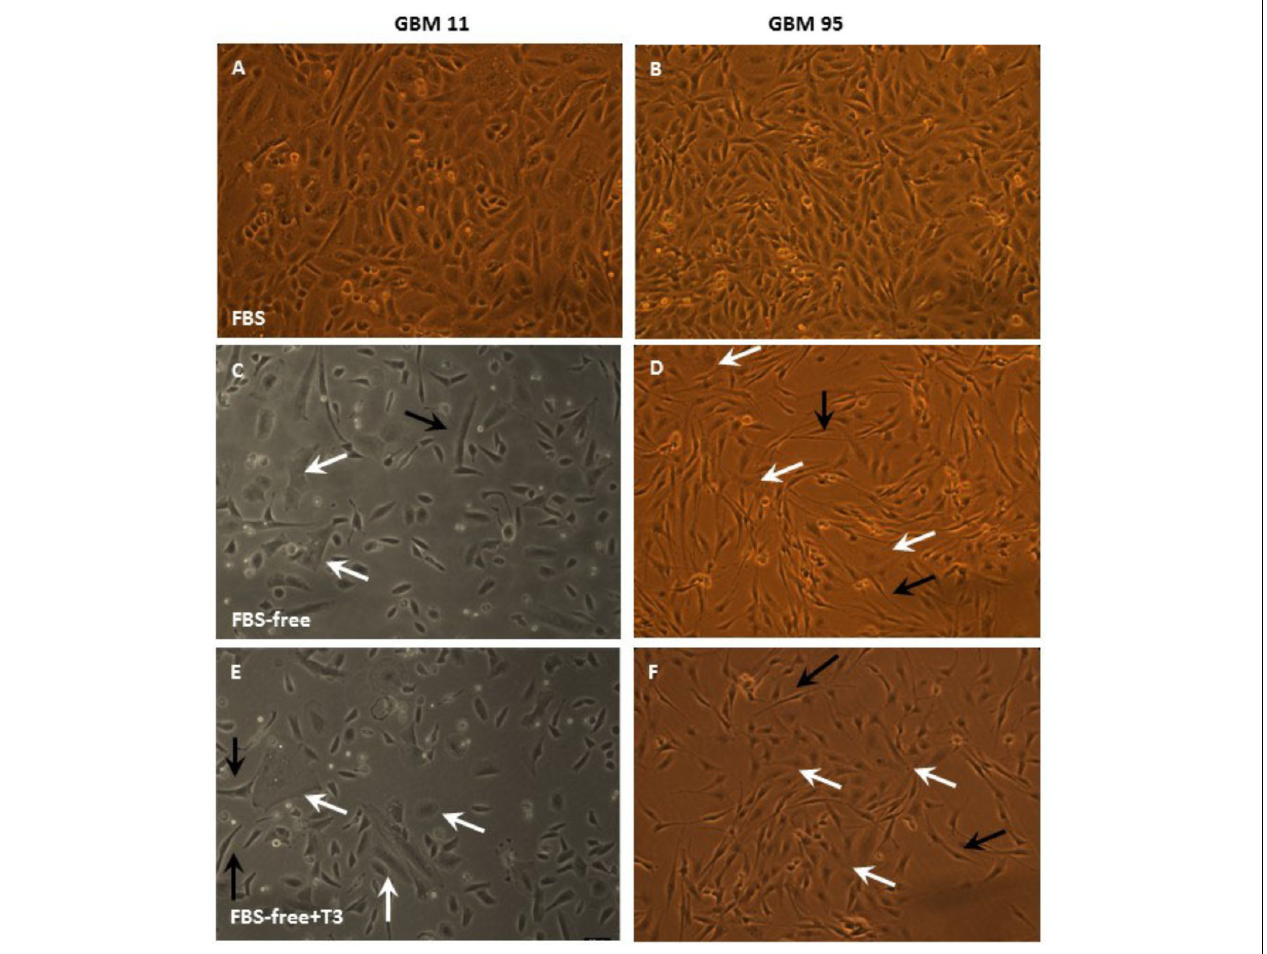
FIGURE 2 | Phase-contrast microscopic images of glioblastoma multiforme GBM-11 and GBM-95 cells cultured in medium containing 10% fetal bovine serum (FBS), medium without serum (FBS-free), and treated with T3 in medium without serum (FBS-free+T3). GBM tumor cells treated with T3 showed large cytoplasmic volume ( E,F , white arrows) and processes ( E,F , black arrows) when compared with those maintained in FBS-free medium (C,D) . GBM-11 and GBM-95 cells maintained in serum-containing medium (A,B)